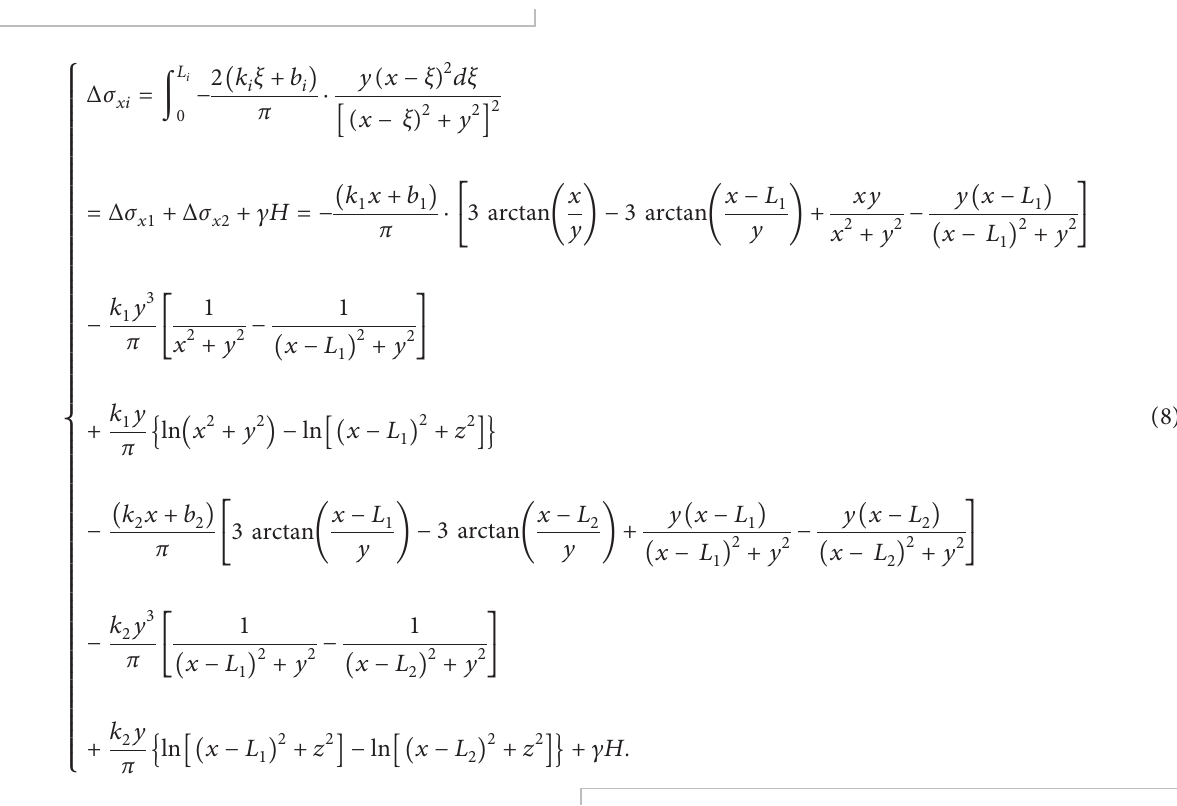
Figure 5: Relationship between three controllable factors, σ lationship between thicknesses, σ 1 , and U e . (c) The relationship between tensile strengths, σ 1 , and U e